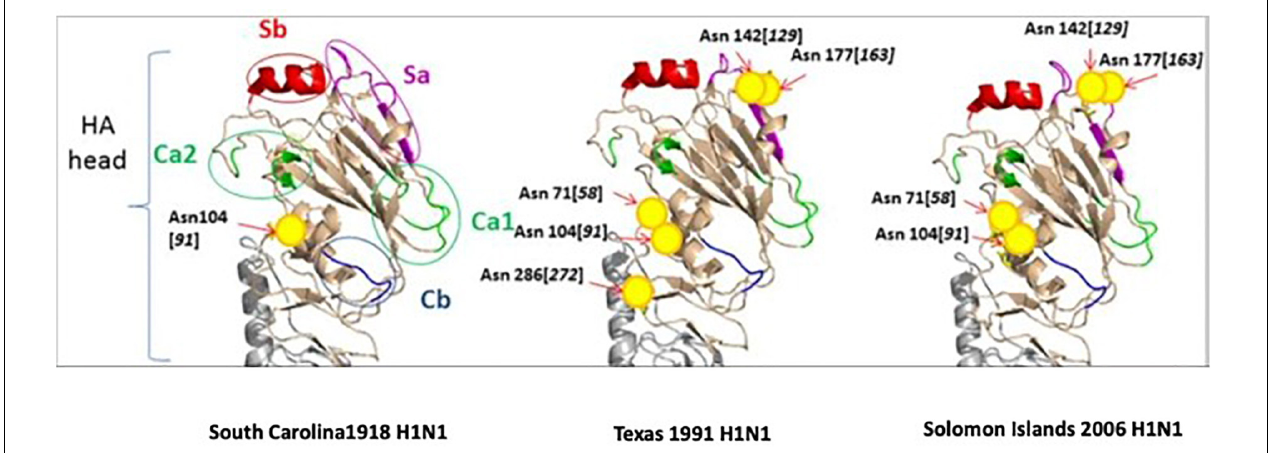
FIGURE 9 | Ribbon diagram of H1N1 pandemic and seasonal strains showing location of glycosylation sites. This figure was obtained with permission from Sun et al. (2013), and it shows comparative structures of the head regions of the hemagglutinin (HA) of H1N1 strains from 1918 (pandemic), 1991 (seasonal), and 2006 (seasonal). Glycosylation sites are indicated by yellow circles. Sa, Sb, Ca, and Cb represent antigenic areas of the HA. Glycosylation sites on the top of the head of the HA (e.g., 142 or 177), which are found on seasonal H1N1 strains and missing on pandemic strains (including 1918 and 2009), can interfere with antibody recognition of antigenic sites but also provide binding sites for SP-D. The numbers indicated by parenthesis represent alternative numbering sometimes used for glycosylation sites.